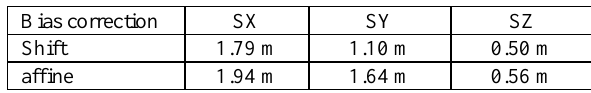
Table 7: Accuracy of 3-D-orientation of model 2 at 13 GCPs